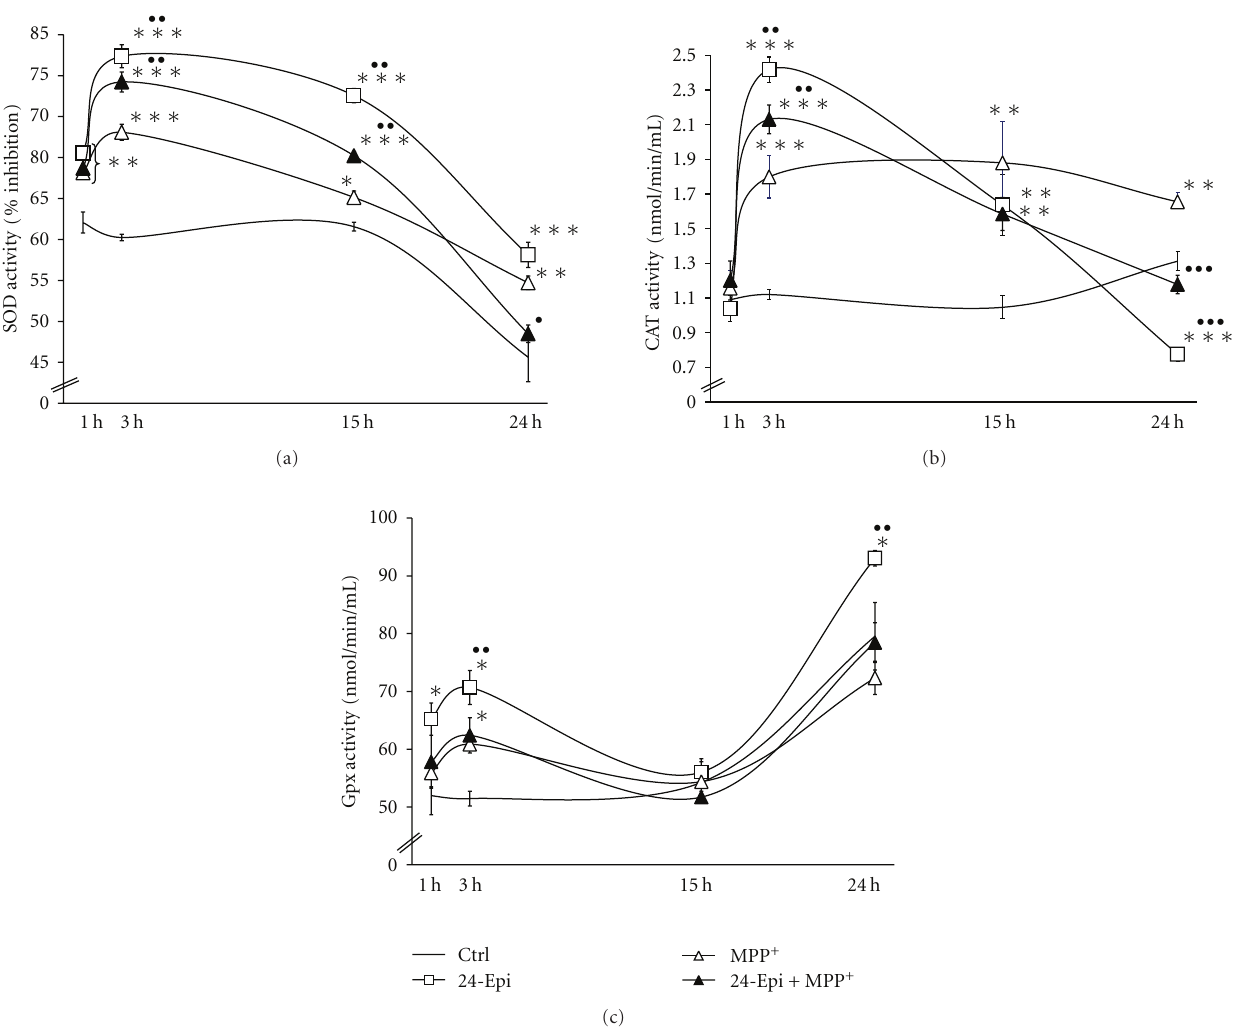
Figure 5: Time course changes in antioxidant enzyme activities in neuronal PC12 cells. (a) SOD activity: administration of 24-Epi alone ( ) induced higher SOD activity than MPP + ( ). Preincubation with 24-Epi prior to MPP + ( ) also augmented SOD activity. A maximal (cid:0) (cid:2) (cid:3) ) induced a constant elevation of CAT activity until 24h. 24-Epi ( ) increase was apparent after 3 h of treatment. (b) CAT activity: MPP + ( (cid:2) (cid:0) heightened CAT activity after 3h of incubation with a subsequent decline in CAT activity becoming less active than the control after 24-h ) increased CAT activity similarly to that observed in cells treated with 24-Epi alone. exposure. Pretreatment with 24-Epi before MPP + ( (cid:3) (c) GPx activity: pretreatment with 24-Epi ( ) induced a maximal increment of GPx activity at 24h while the increase with MPP + ( ) and (cid:0) (cid:2) ) was less pronounced. Data are expressed as means ± S.E.M. n = 3. ∗ P < . 05, ∗∗ P < . 01, and ∗∗∗ P < . 001 versus Ctrl; 24-Epi + MPP+ ( (cid:3) • P <